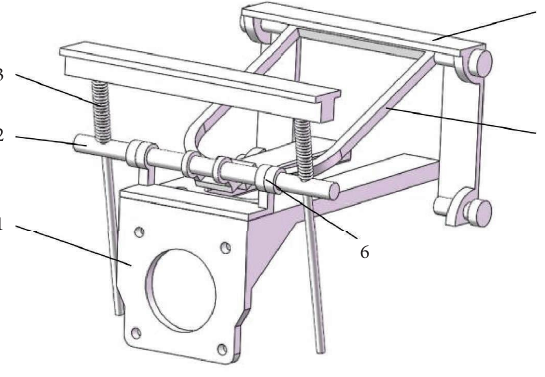
Figure 3: Chassis suspension mechanism. (1) Motor bracket. (2) Rocker link. (3) Spring. (4) Rocker bracket. (5) Rocker arm. (6) Bearing.